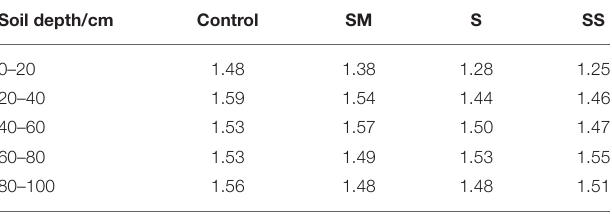
TABLE 1 | Soil bulk density under the Control, SM, S and SS